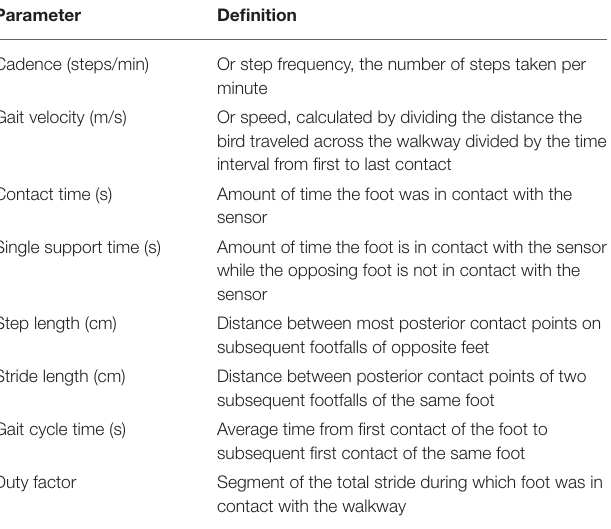
TABLE 1 | Gait parameters and